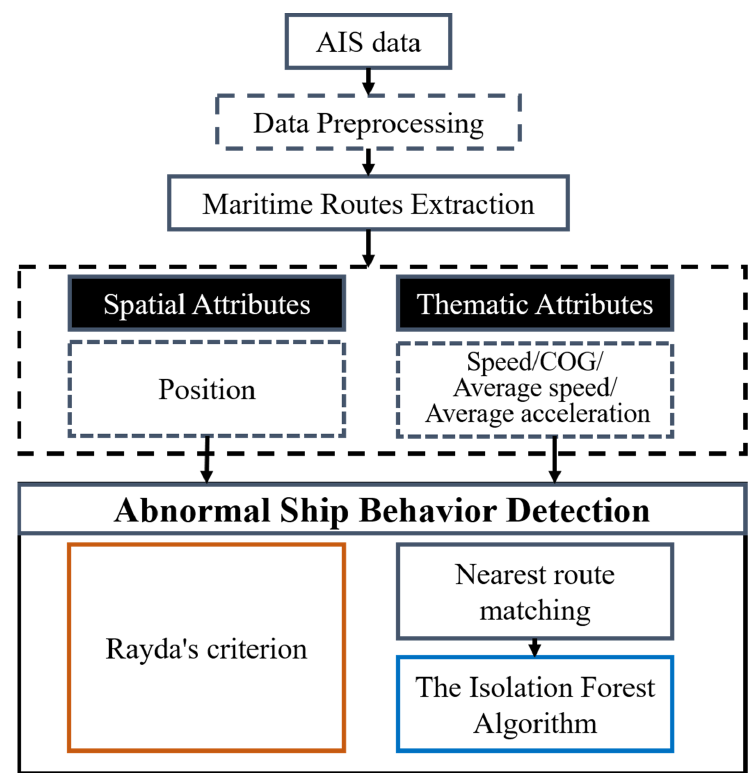
Figure 2. Framework for abnormal detection.